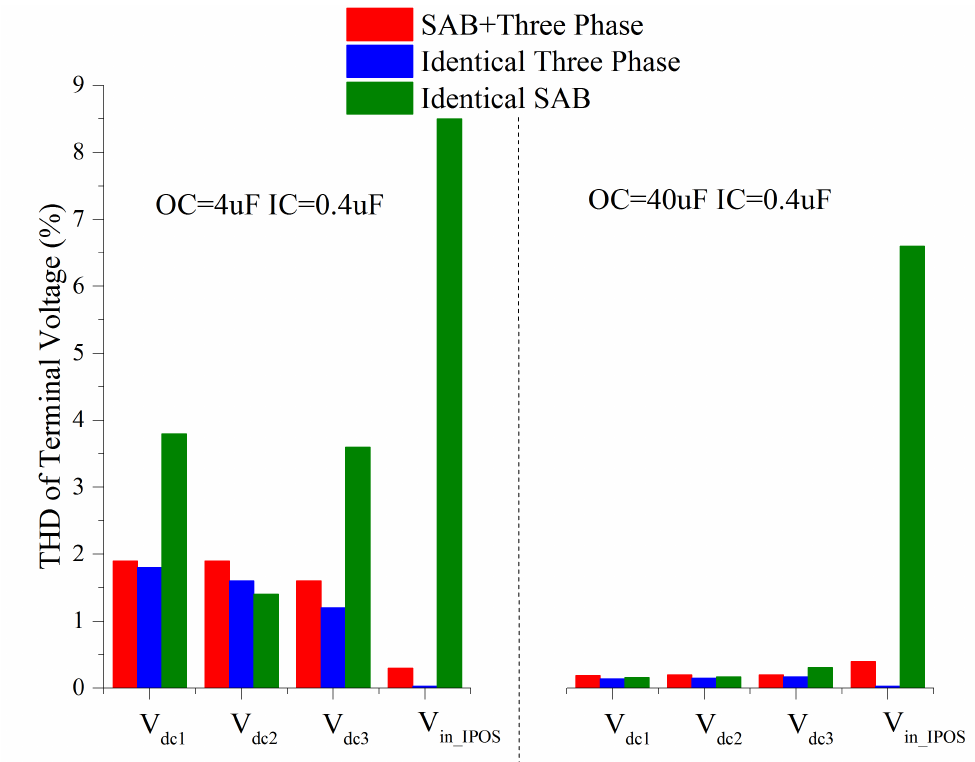
Figure 9. THD of terminal voltages at particular OC and